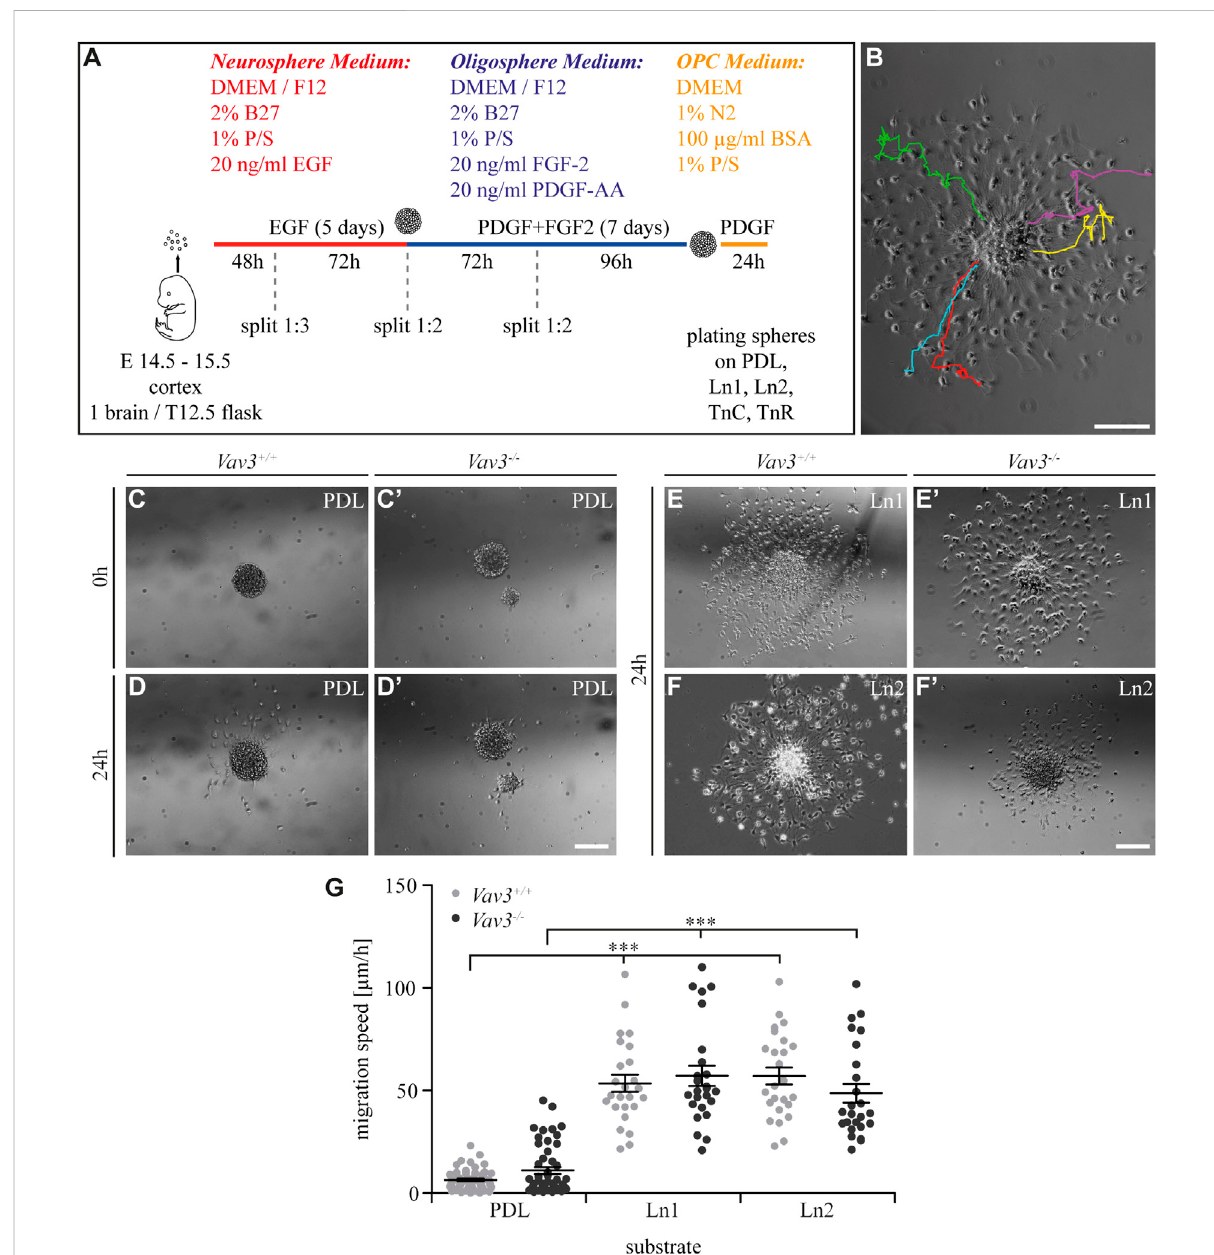
FIGURE 1 Generation of oligospheres and migration speed of OPCs on PDL and laminins. (A) Protocol for the generation of OPCs and the migration assay. (B) Representative image of a plated oligosphere with tracked cells and their individual traces. (C + C 9 ) Plated Vav3-expressing ( Vav3 +/+ ) and Vav3-de fi cient ( Vav3 − / − )oligospheresonPDLsubstrate(control)attimepoint0 h. (D+D 9 ) PlatedoligospheresofeithergenotypeonPDLafter24 hofmigrationtime. (E+E 9 ) Oligospheresofeithergenotypeonlaminin-1(Ln1)substrateafter24 hofmigration. (F+F 9 ) Bothgenotypesofoligospheresplatedonlaminin-2(Ln2) after 24 h of migration. (G) The quanti fi cation of migration speed [in µm/h] revealed no genotype-dependent effect of OPCs on different substrates but indicatedasigni fi cantlyincreasedmigrationvelocityofOPCsonlamininscomparedtothecontrolPDL.Dataareexpressedasmean±SEM.Singlevaluesare depictedasdatapoints.ANOVAwasperformedanddependingonnormaldistributionofvalues,BonferroniposttestorKruskal – WallisandDunn ’ sposttest followed (*** p ≤ 0.001). PDL: N = 10, n = 50; laminins: N = 5, n = 25. Scale: 200